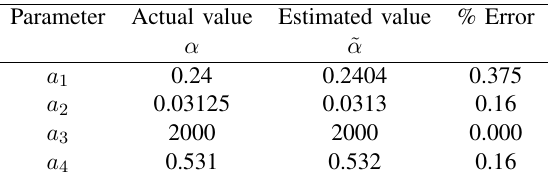
Table 2 : Problem 4: The parameter estimates and errors.